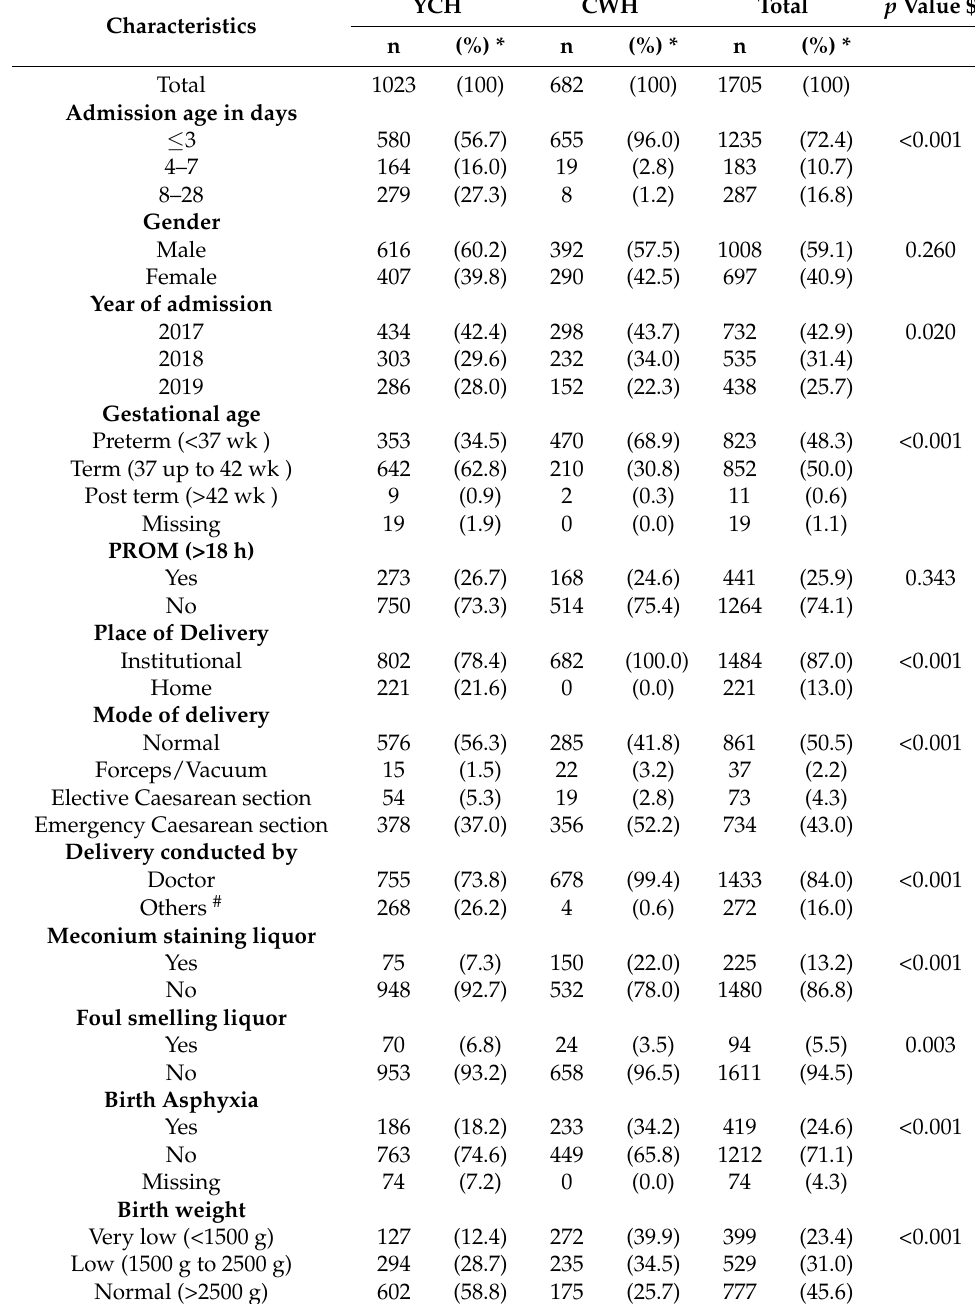
Table 2. Demographic, perinatal, and clinical characteristics of neonates with clinically suspected sepsis admitted to the NICU of two tertiary care hospitals in Yangon, Myanmar, January 2017